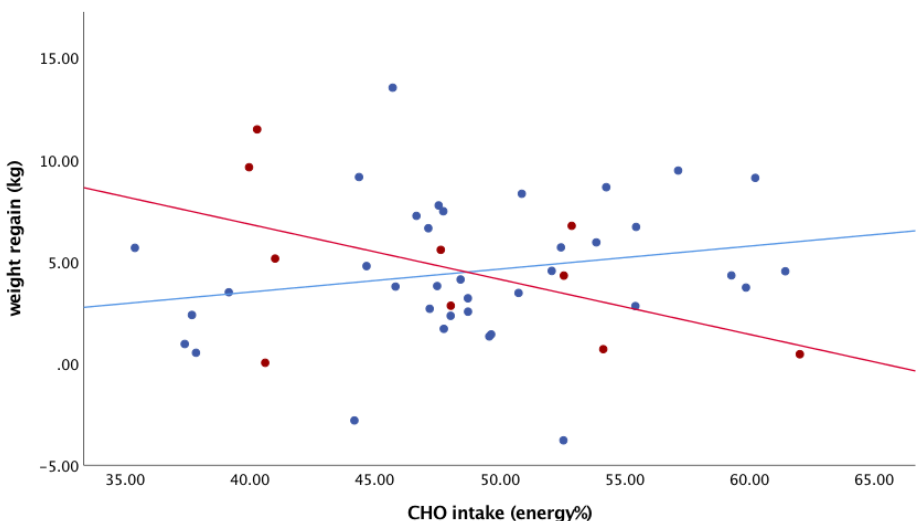
Figure 3. Associations between carbohydrate intake and weight regain in the participants with baseline normo-